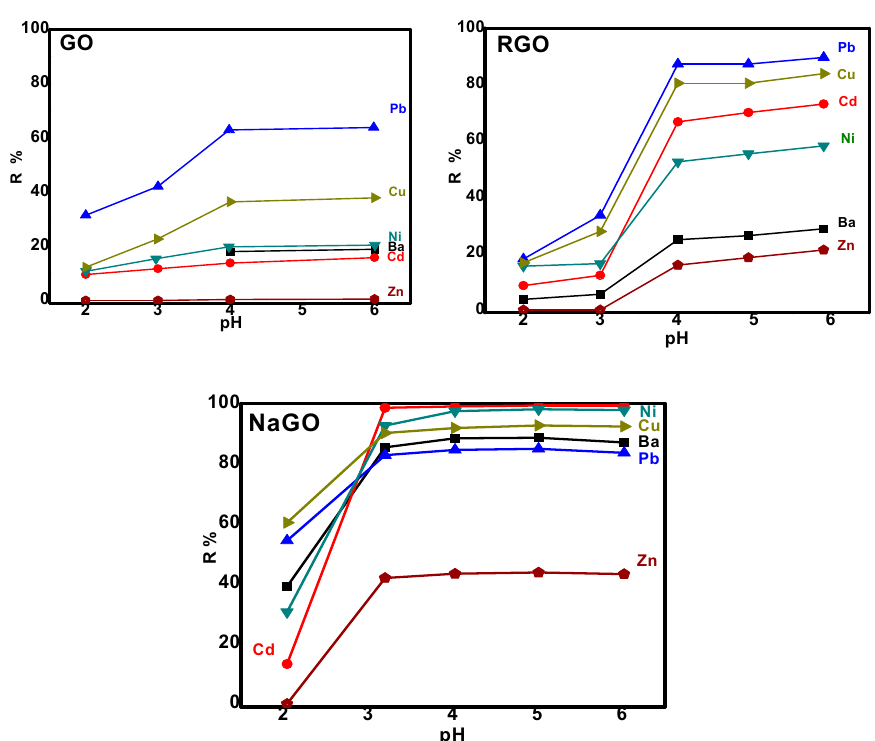
Figure 2. Extraction recoveries at different pH values with graphene oxide (GO), reduced graphene oxide (RGO) and NaOH modified graphene oxide (NaGO).